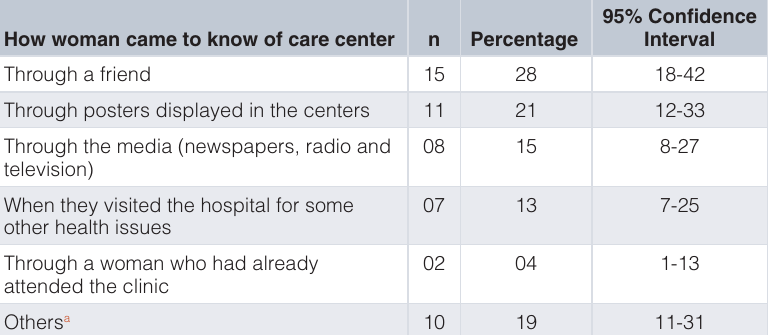
Table 4. In case of self-referral, how the women came to know of the care centers (n=53).